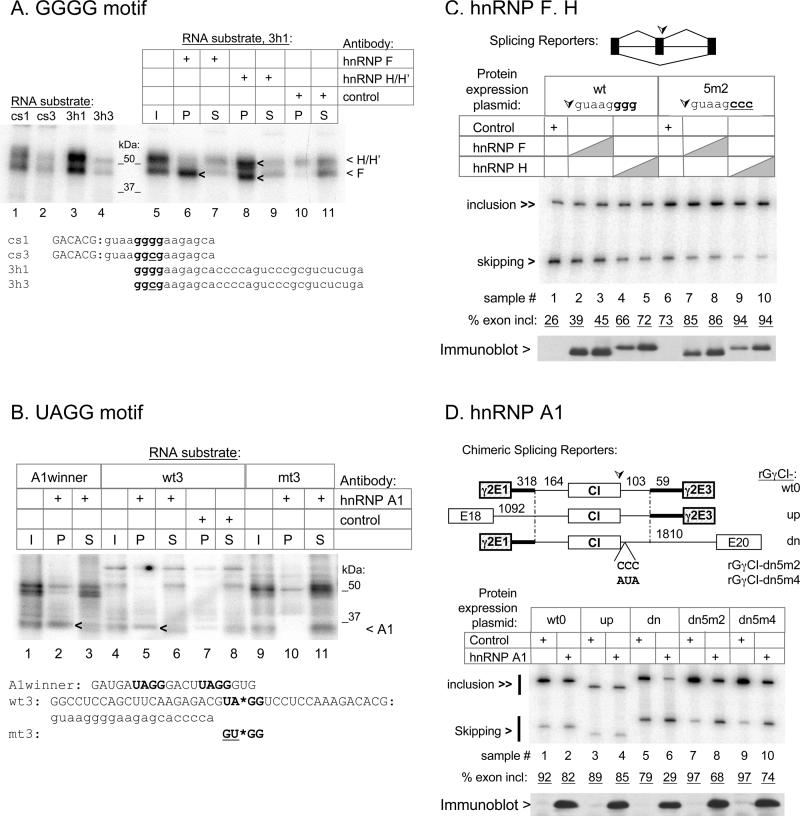
Identification and Functional Roles of Protein Factors That Bind to
GGGG and UAGG Motifs
(A) Detection of protein binding to the 5′ splice site
GGGG motif by UV crosslinking in HeLa nuclear extract. Wild-type (cs1 and 3h1) and mutant (cs3 and 3h3) RNA substrates were internally labeled at guanosine nucleotides; mutations are underscored. Pattern of UV crosslinking is shown following RNase digestion and SDS-PAGE (lanes 1–4). Immunoprecipitation reactions (lanes 5–11) contained the 3h1 substrate together with antibody specific for hnRNP F or H/H′; control samples contained preimmune rabbit serum. Gel panel shows the pellet (P), supernatant (S), and input (I) of the immunoprecipitation reactions following SDS-PAGE. The positions of hnRNP H/H′ and F (arrowheads) and protein molecular weight standards (in kilodaltons) are indicated. The hnRNP F and H/H′ antibodies were a gift of C. Milcarek.
(B) UV crosslinking of exonic position 93 UAGG motif in HeLa nuclear extract. RNA substrates were prepared with a single radiolabeled nucleotide as indicated by the asterisk; sequences are shown (bottom). The wild-type (wt3) and mutant (mt3) substrates are identical except for the underscored mutation. The A1winner substrate corresponds to the high-affinity hnRNP A1 binding sequence previously identified by SELEX. The position of hnRNP A1 is indicated (arrowhead). Monoclonal antibody 9H10 was a gift of G. Dreyfuss.(C) Exon inclusion is enhanced by co-expression of hnRNP F or H. Gel panel shows splicing pattern resulting from co-transfection of wild-type (wt) or mutant (5m2) splicing reporter with hnRNP F or H expression plasmid; splicing reporters are identical to those shown in Figure 1A. Control samples were transfected with empty vector; grey wedge indicates two levels (4 and 6 μg) of protein expression plasmid. Arrowhead indicates 5′ splice site. For immunoblot verification of transfected protein expression (bottom), nuclear extracts from transfected cells were separated by SDS-PAGE, transferred to nylon membrane, and developed with an antibody specific for the Xpress tag at the N-terminus of each pcDNA–protein sample. Raw percent exon inclusion values are shown below gel image.(D) Silencing effect of hnRNP A1 requires the intact 5′ splice site
GGGG motif and full-length downstream intron. Structures of chimeric splicing reporters are shown in which the CI cassette exon and intron flanks were introduced into an unrelated splicing reporter containing sequences from the GABAA receptor γ2 transcript: rGγCI-wt0 (both introns truncated), -up (full-length upstream intron, truncated downstream intron), and -dn (truncated upstream intron, full-length downstream intron). Numbers above indicate length of each intron segment in nucleotides. Arrowhead indicates 5′ splice site. The splicing reporters rGγCI-dn5m2 and -dn5m4 contain the full-length downstream intron with 5′ splice site mutations of Figure 1A. Gel panel shows splicing pattern resulting from co-transfection of splicing reporter with hnRNP A1 expression plasmid or vector control. Immunoblot verification of transfected protein expression (bottom) is as described in (C).